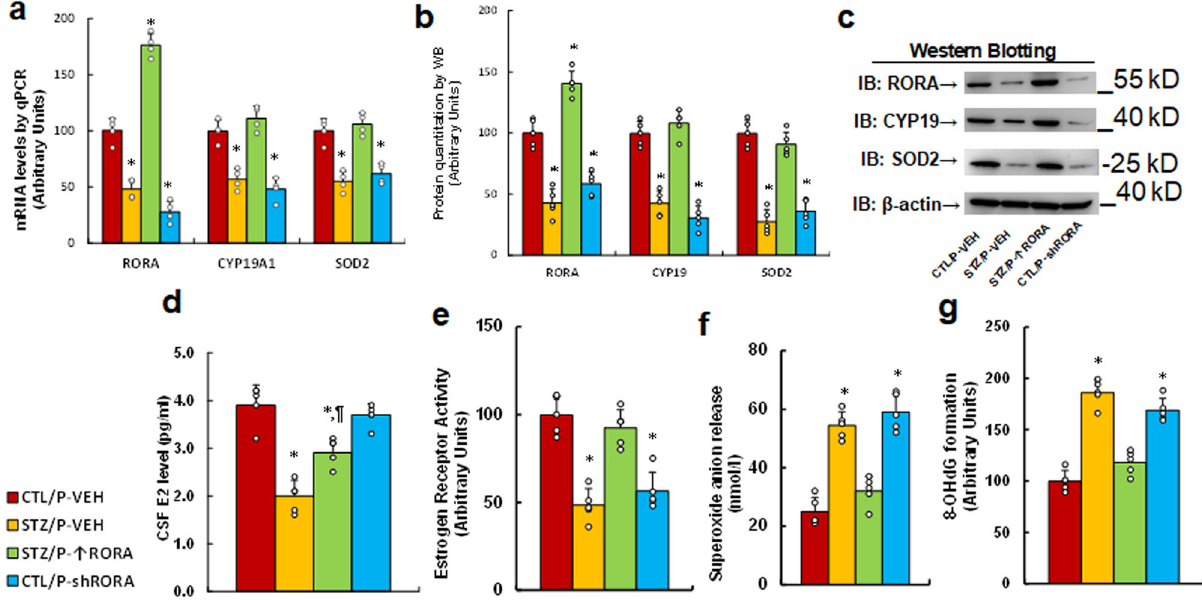
Fig. 6 Postnatal expression of RORA in the amygdala reverses maternal diabetes-induced gene expression and oxidative stress in offspring, while RORA knockdown mimics this effect. The male offspring from either the control (CTL) or maternal diabetes (STZ) groups received either vehicle (P- VEH), or lentivirus infusion for either RORA expression (P- ↑ RORA) or RORA knockdown (P-shRORA) at 6 weeks old, and the male offspring were sacri fi ced for further biomedical analysis at 8 weeks old. a – d The amygdala tissues were isolated for further analysis as described as follows: a mRNA levels by qPCR, n = 4. b The quantitation of protein levels, n = 5. c The representative pictures for western blotting. d CSF E2 levels, n = 5. e Estrogen receptor activity, n = 5. f In vivo superoxide anion release, n = 5. g The amygdala tissues were isolated for the measurement of 8-OHdG formation, n = 5. *, P < 0.0001, vs. CTL/P-VEH group; ¶, P = 0.002, vs. STZ/P-VEH group. Data were expressed as mean ±